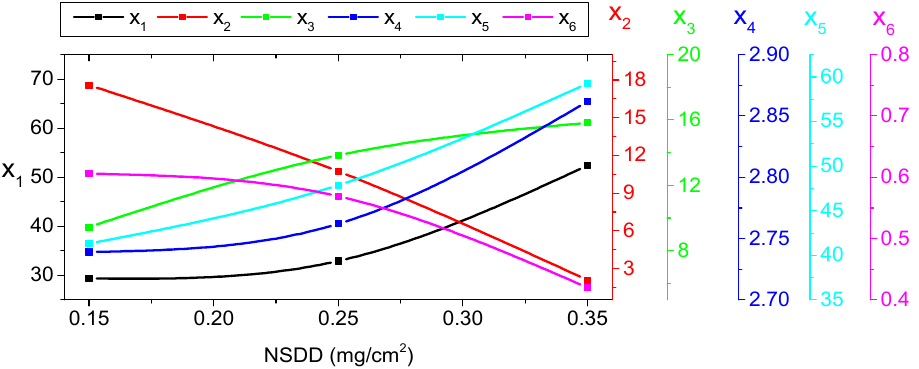
Figure 11. The impact of NSDD on indicator shift.